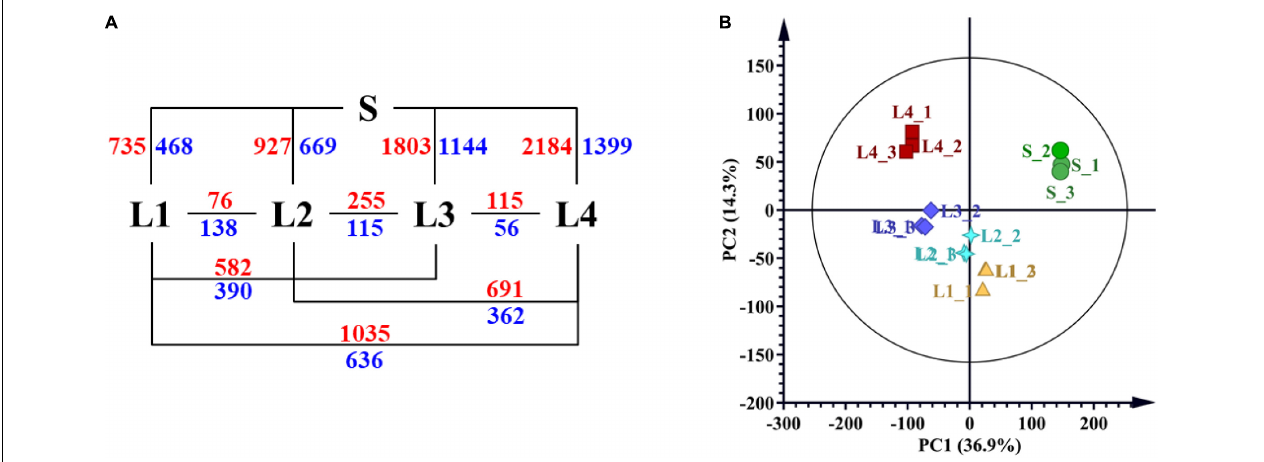
FIGURE 4 | RNA-seq results of different juice sacs. (A) Numbers of differentially expressed genes (DEGs) from the pairwise comparison of different juice sacs. (B) PCA analysis presenting the difference of RNA-seq results of different samples. S, juice sacs from small-size fruit. L1–L4, juice sacs from large-size fruit, which were classified according to the granulation degree.